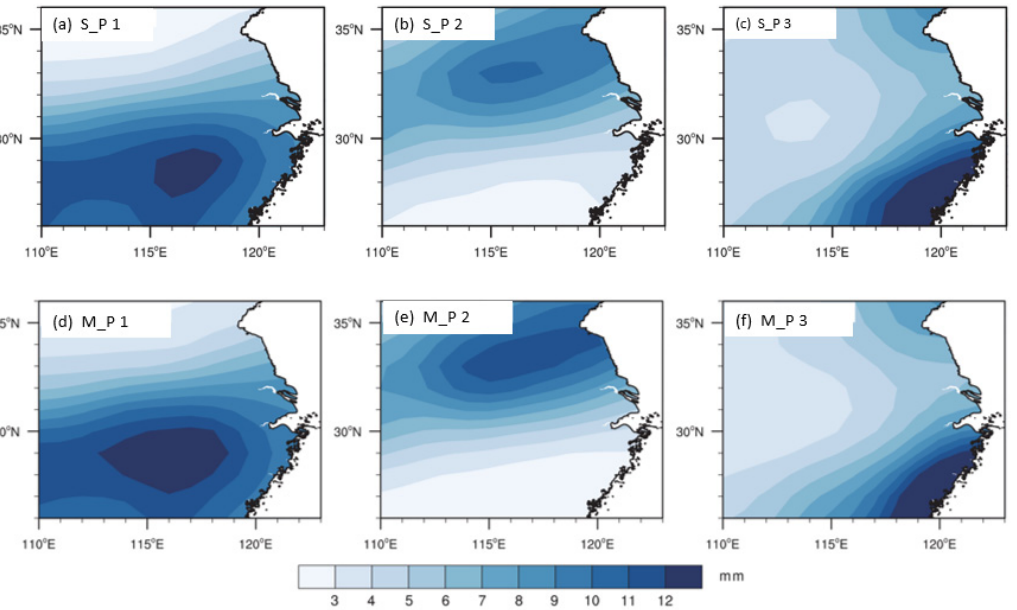
Figure 8. Composite heavy rain patterns in the Jianghuai Region classified by the transfer learning CNN model (unit: mm). Table 2. The correlation coefficients between the transfer learning CNN model and the heavy rain- fall of typical mode patterns in samples.